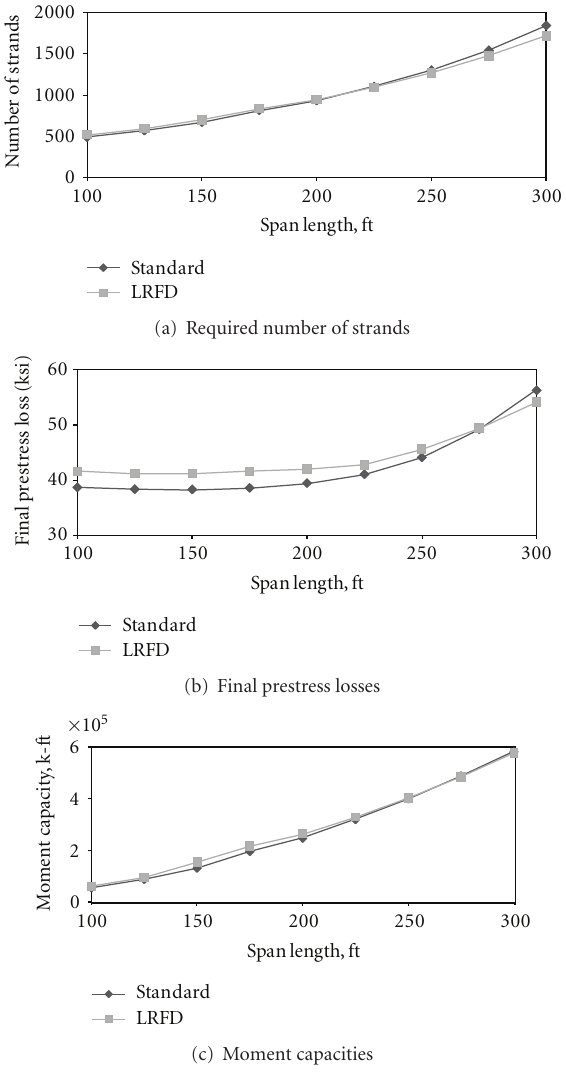
Figure 5: Comparison in box girder (seven cells spaced at 9ft) for di ff erent span